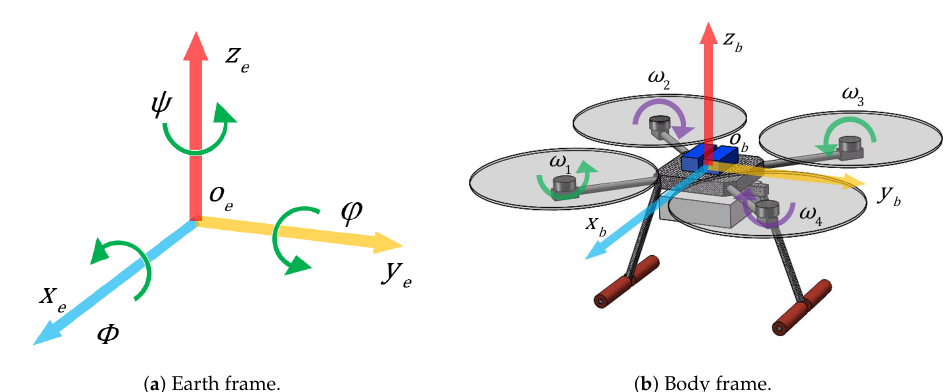
Figure 1. Coordinate definition of the